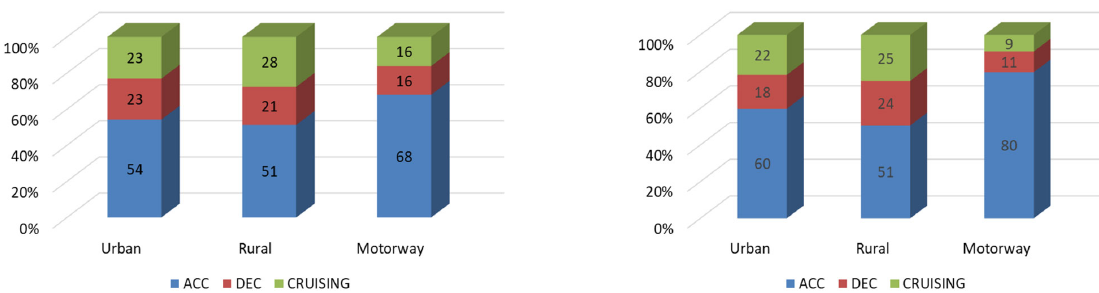
Figure 5. Percentage share of drive modes for driving in a lower than optimal gear for Vehicle 1 (on the right side) and Vehicle 2 (on the left side) during driving on city roads, rural roads, and motorways.